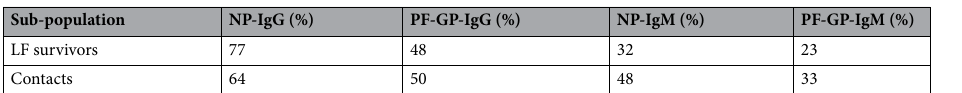
Sub-population NP-IgG